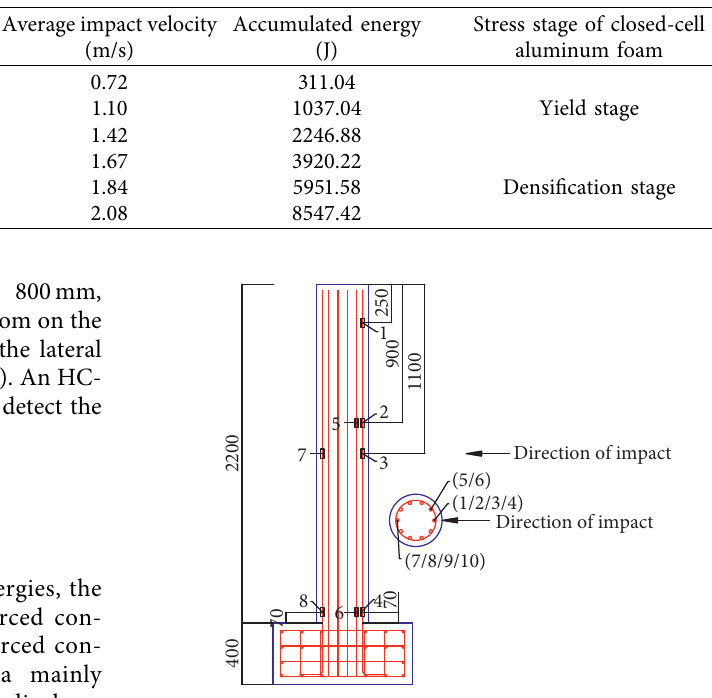
Table 5: Impact scheme.